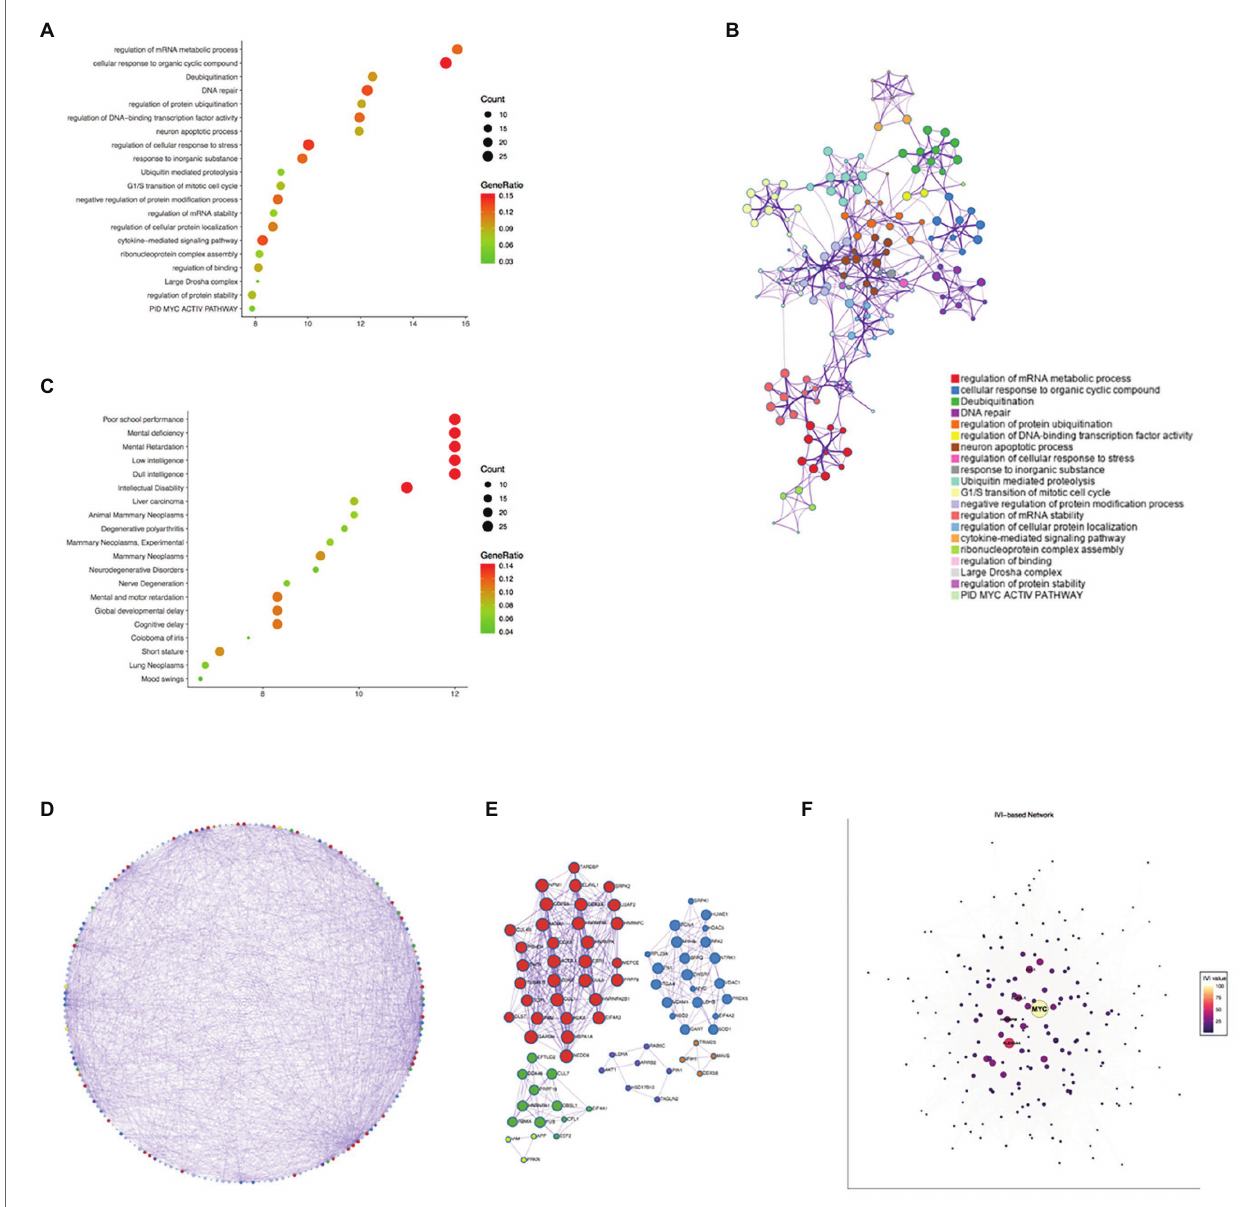
FIGURE 6 | Enrichment analysis of PPIA functional networks in HCC. (A) Enrichment analysis of PPIA related genes using Metascape. The nodes represent different enriched terms. The size of nodes represent the count of genes and the color represent the GeneRatio. (B) The network of enriched terms colored by cluster ID, the nodes that share the same cluster ID are typically close to each other. The size of nodes represent the count of genes. (C) Enrichment analysis of gene-disease association using Metascape. The nodes represent different enriched terms. The size of nodes represent the count of genes and the color represent the GeneRatio. (D,E) Protein-protein interaction network carried out with Metascape and gene lists in Molecular Complex Detection (MCODE) networks. The nodes were colored by MCODE, and nodes that share the same MCODE are typically close to each other. The size of nodes represent the count of genes. (F) The visualization of network according to Integrated Value of Influence (IVI) values. The nodes represent different co-expressed genes. A centrality measure was applied to the size and color of network nodes according to IVI values. PPIA, peptidylprolyl isomerase A; HCC, hepatocellular carcinoma; and MCODE, the Molecular Complex